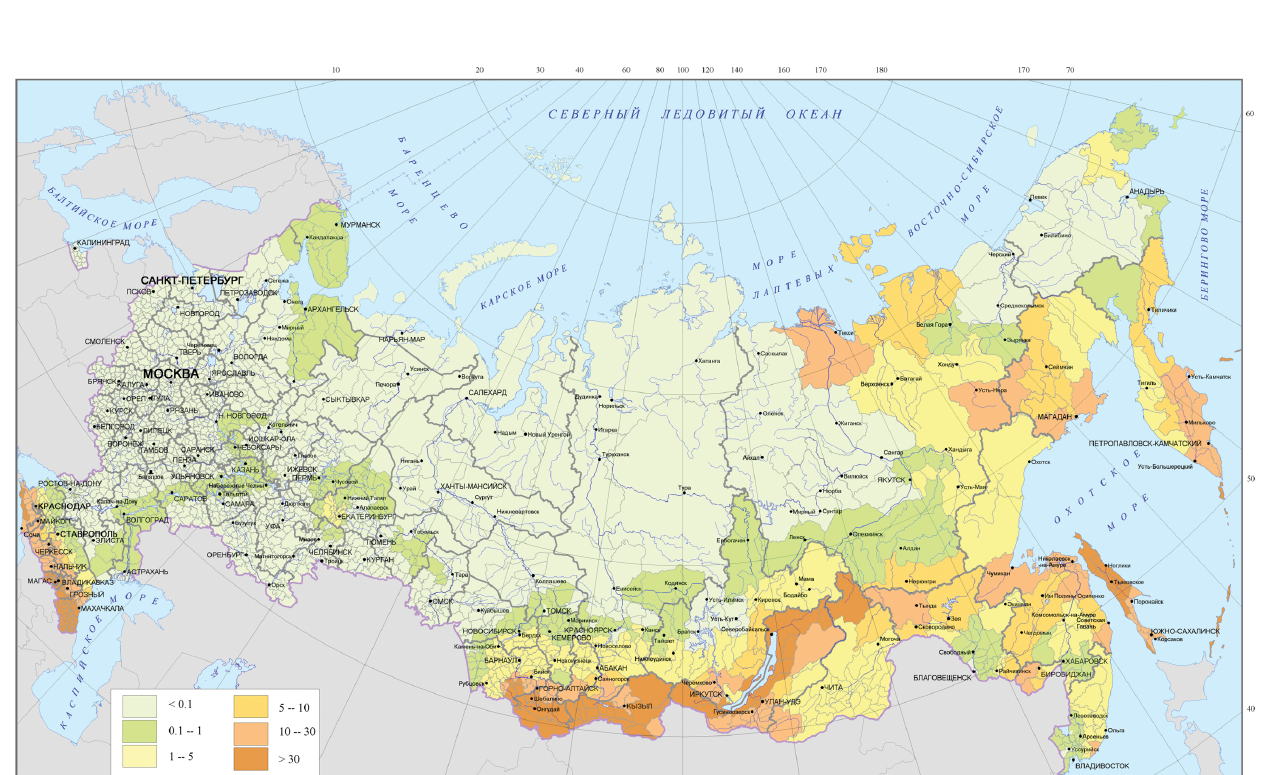
Fig. 1. Map of individual seismic risk R s 1, 10 − 5 yr − 1 , for the territory of the Russian Federation.